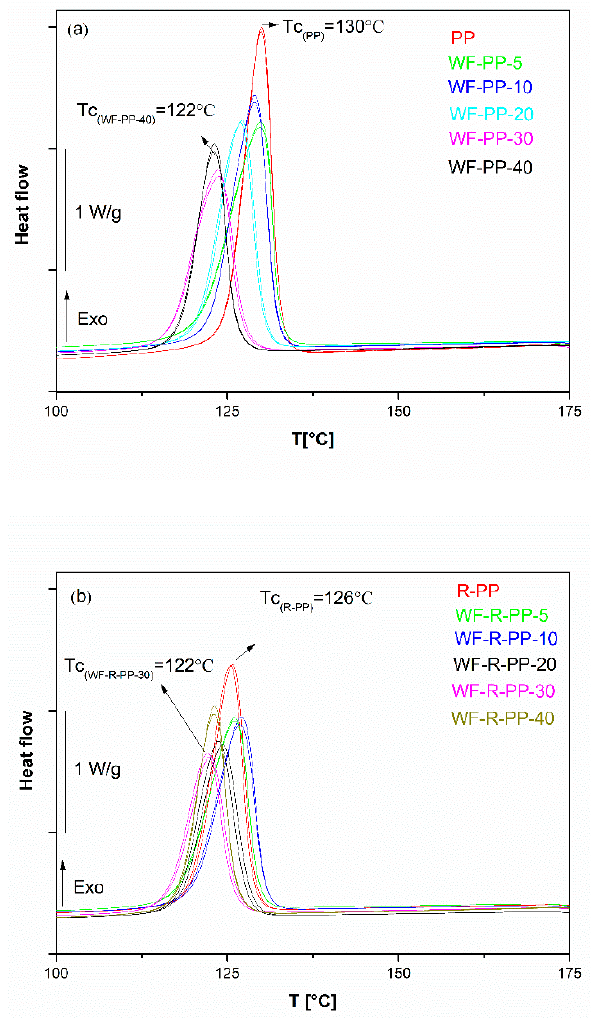
Figure 5. Di ff erential scanning calorimetry (DSC) thermograms of ( a ) WF-PP composites and Figure 5. Differential scanning calorimetry (DSC) thermograms of ( a ) WF ‐ PP composites and ( b ) WF ‐ ( b ) WF-R-PP R ‐ PP composites.